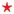
CFS-PPy/DBS (■) and CFS-PPy/TF (★) showing in a: Diffusion coefficients Dox (upon oxidation) obtained from Eqs 2 and 3 against the applied frequency f and b: the strain rate νox against diffusion coefficients Dox.The dashed lines represent the linear fit and shown for orientations.